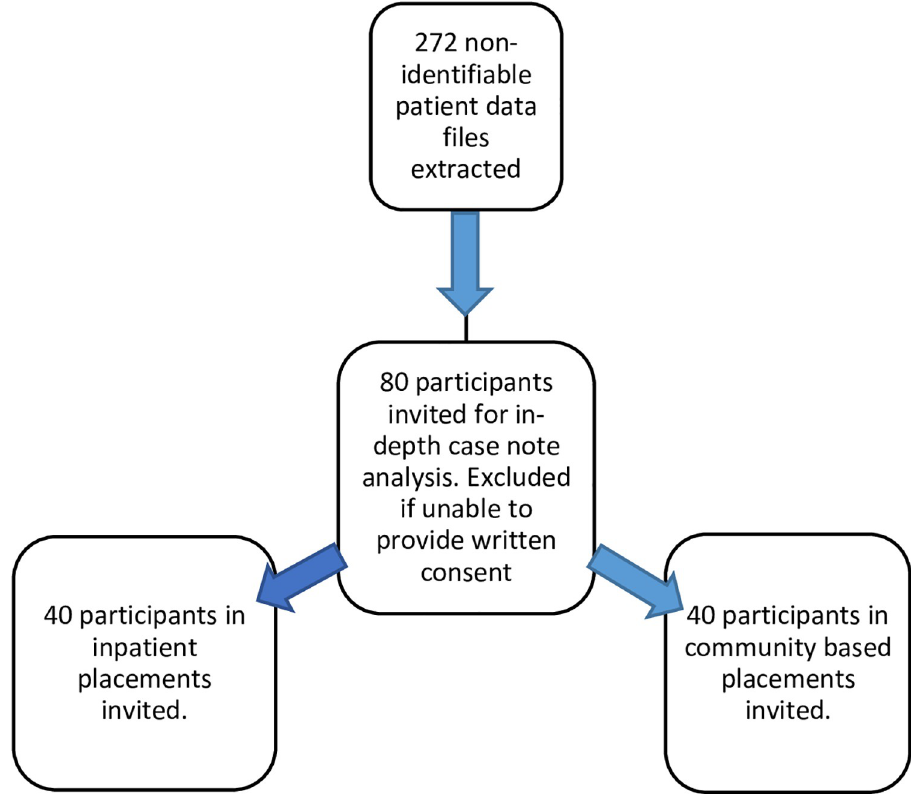
Fig 1. Recruitment phases for the quantitative